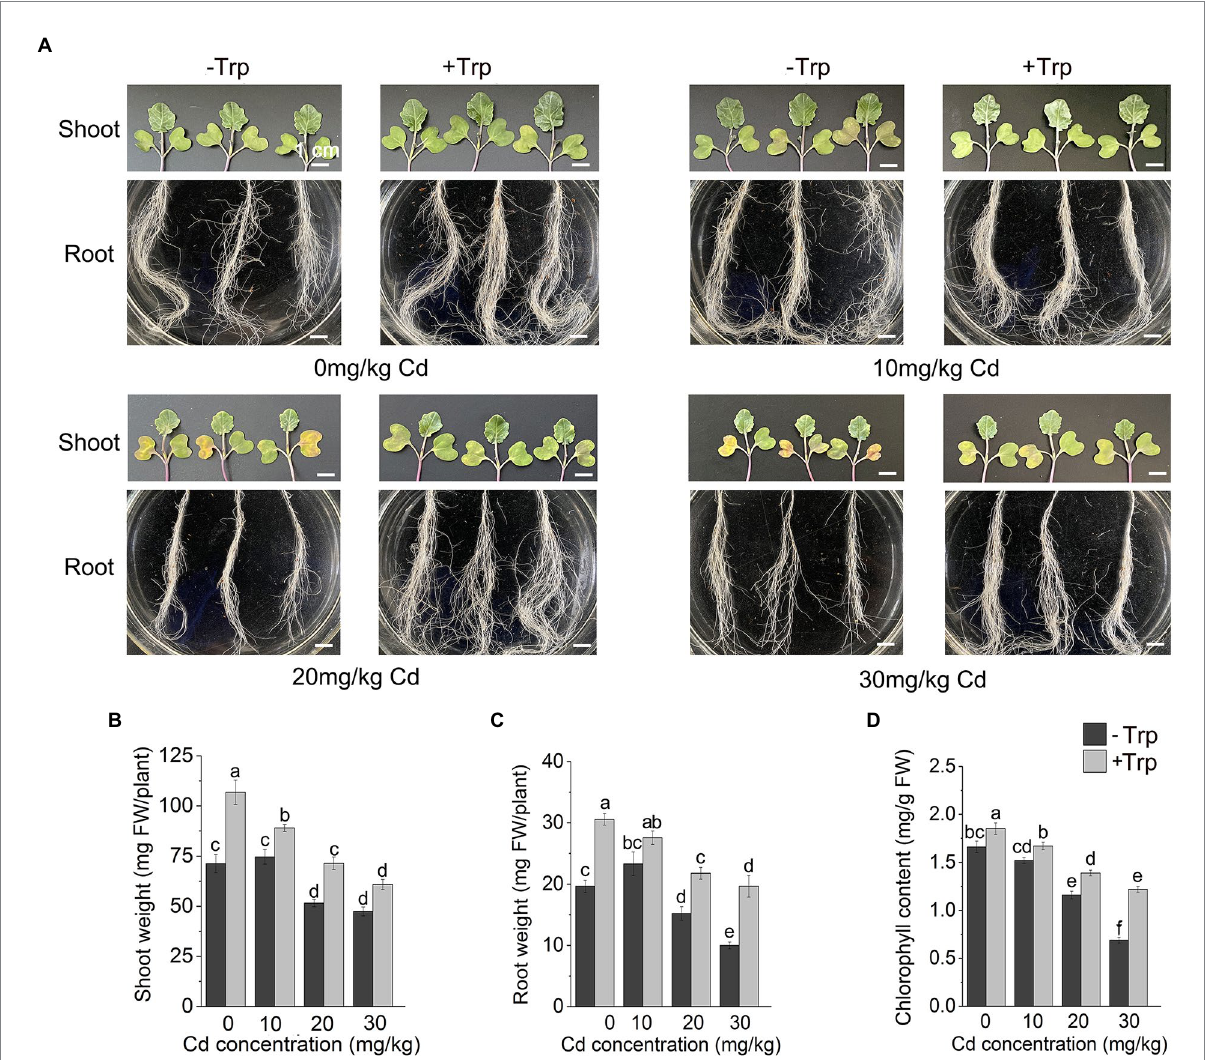
FIGURE 1 Effect of Trp on growth and development under Cd stress. (A) The growth of shoot and root. (B) Shoot weight. (C) Root weight. (D) Chlorophyll content. Data were averaged from three independent replicates ± SD. Scale bar = 1 cm. Different letters represent significant differences between different treatments ( p ≤ 0.05). FW, fresh